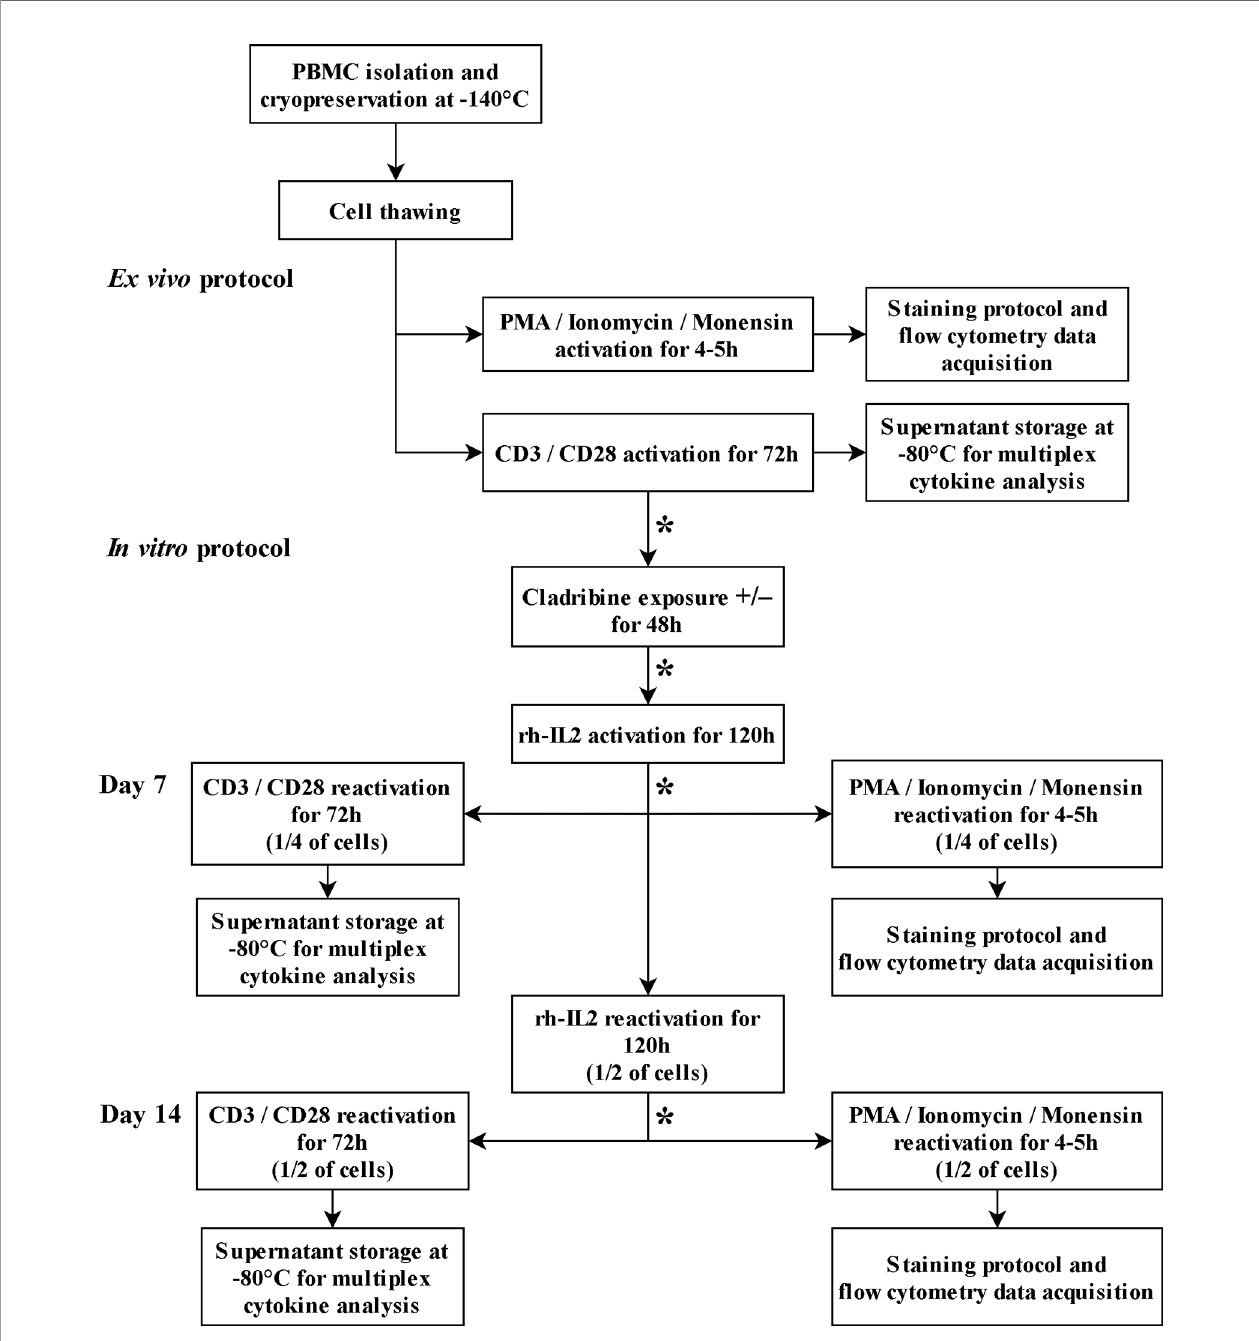
FIGURE 1 | T cell culture and activation protocols. The asterisk (*) between steps indicates cell wash, cell count, and viability